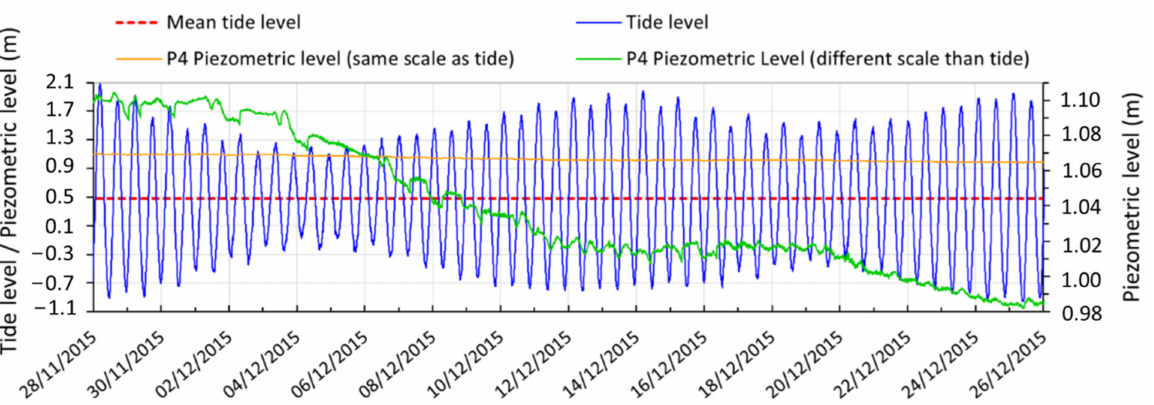
Figure 8. Tide level records over a 4-week period, with indication of the mean sea level (local datum) and the evolution of the piezometric level in the observation point P4. For a better visualization of the latter, P4 fluctuations have been plotted using two different scales. On the left Y axis, the scale coincides with that used for the tidal level, in order to compare both variables. On the right Y axis, the scale has been enlarged in order to display small amplitude